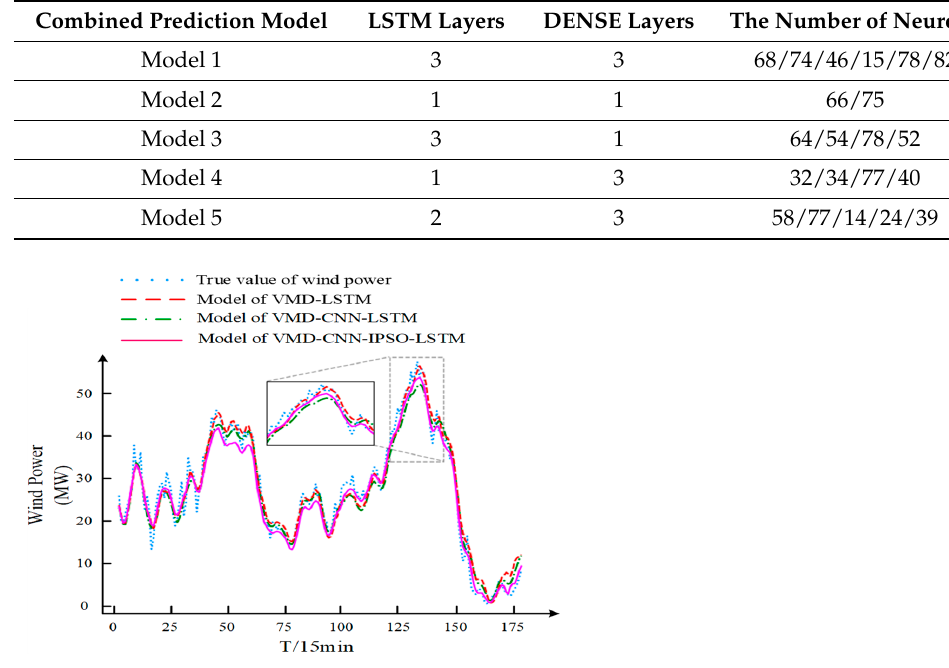
Figure 9. Wind power predicted value and real value of each model in the new data set.